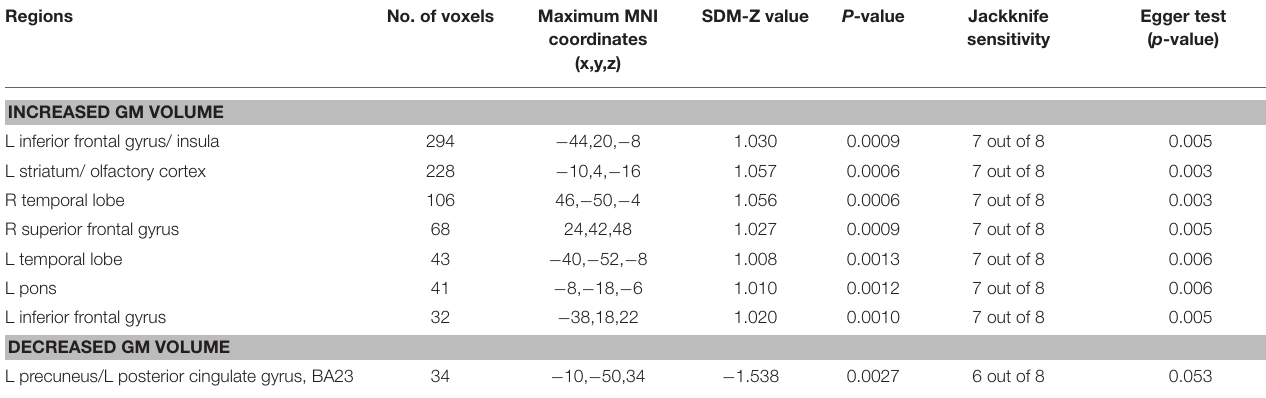
TABLE 3 | The subgroup meta-analysis of studies performed on a 3.0T scanner: GM volume differences in ET patients relative to healthy controls.